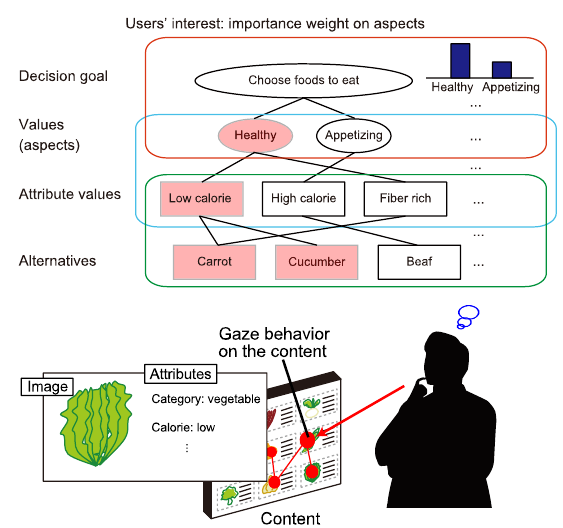
Figure 1. Example situation of users’ choice behavior during content browsing and user’s internal hierarchical structure based on means-end chain